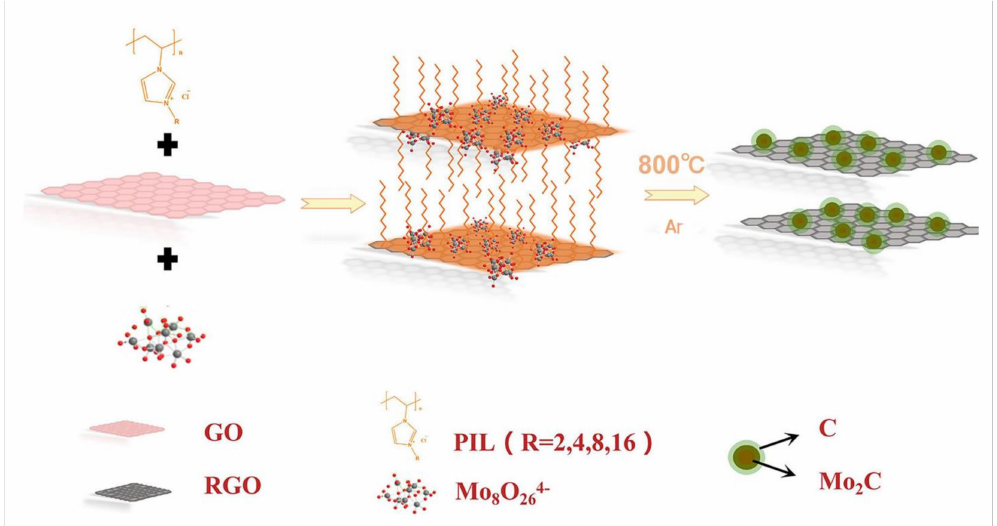
Figure 7. Schematic illustration of the synthetic process of Mo 2 C − RGO. Reprinted with permission from ref. [113], copyright 2019 ACS